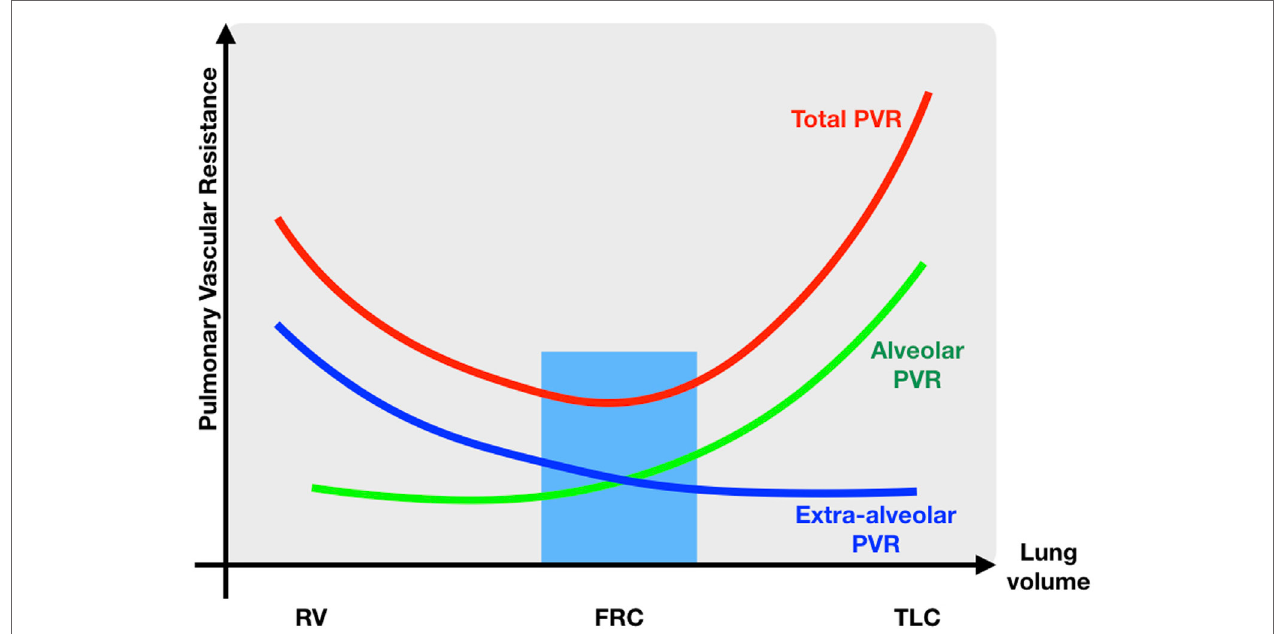
FigURe 5 | Relationship between PVR and lung volume. RV residual volume; FRC, functional residual capacity; TLC, total lung capacity; PVR, pulmonary vascular resistance; blue zone lowest pulmonary vascular